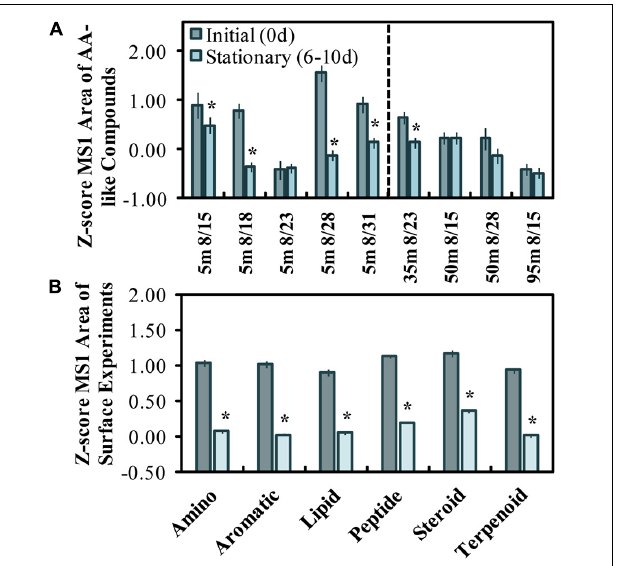
FIGURE 3 | Z -scored peak areas of amino acid-like compounds ( n = 21) in surface experiments determined by LC-MS/MS, where dates on the x-axis refer to the experiment start date and sample depth (A) . Mean z -score changes by 6 molecular feature classes initially abundant in surface experiments ( n = 85), excluding the 8/23 experiment (B) . Error bars represent standard errors, and the * above the bars refers to a significant (two-tailed t -test, p < 0.05) decrease between initial and stationary phase. A z -score change of –1.0 refers to one standard deviation